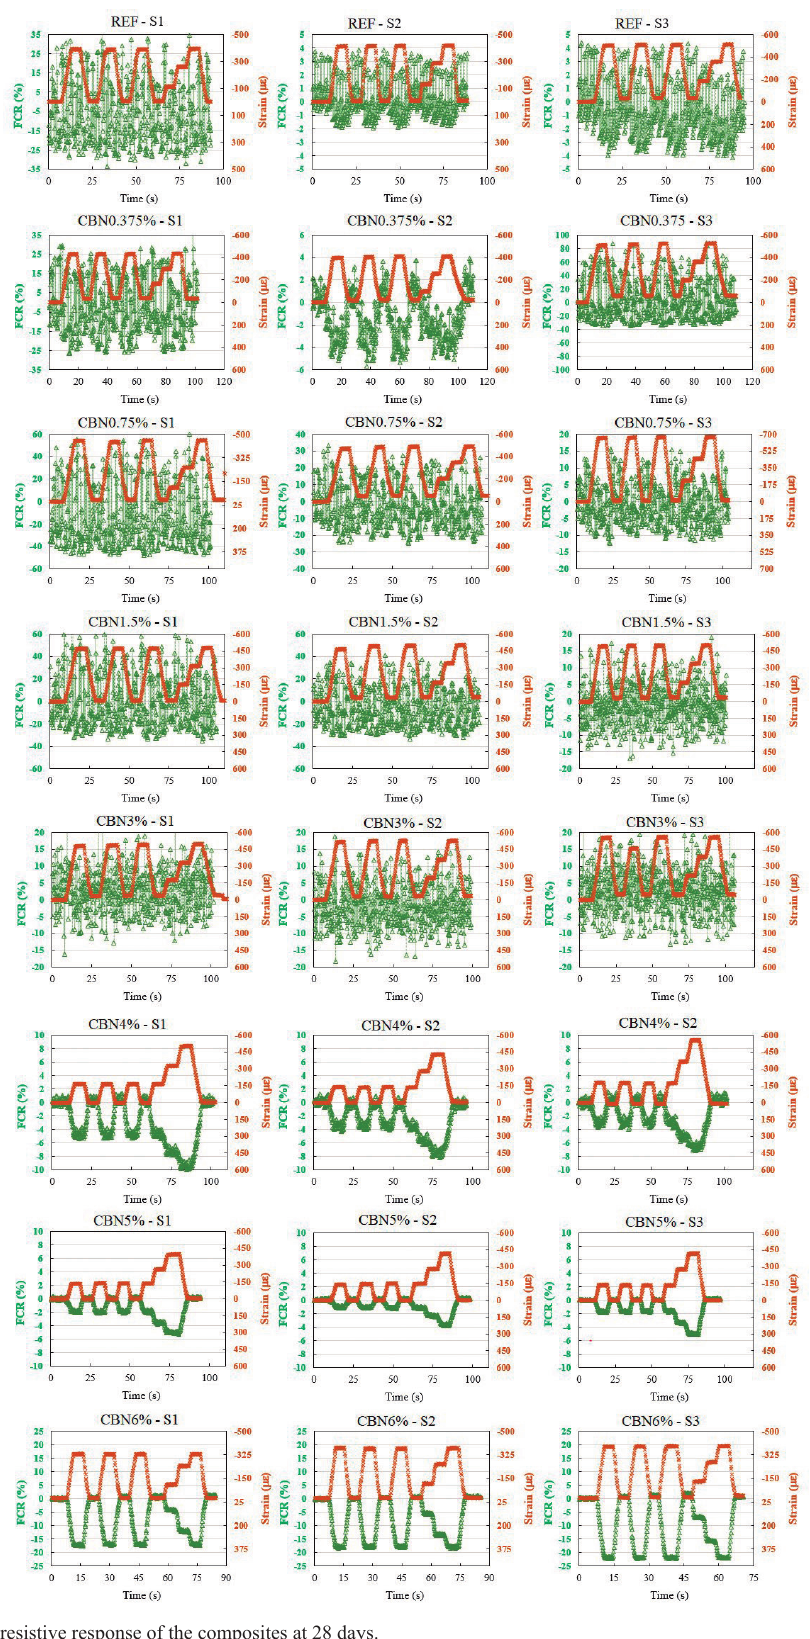
Figure 10. Piezoresistive response of the composites at 28